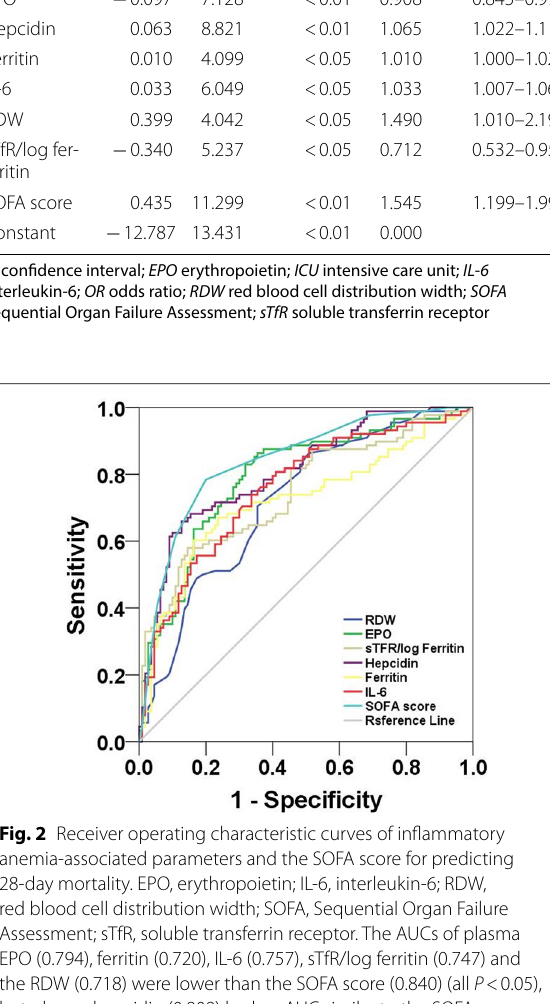
Table 4 Plasma levels of EPO, hepcidin, ferritin, IL-6, sTfR/ log ferritin as well as the RDW and SOFA score on day 1 of ICU admission were independent predictors of 28-day mortality in patients with sepsis